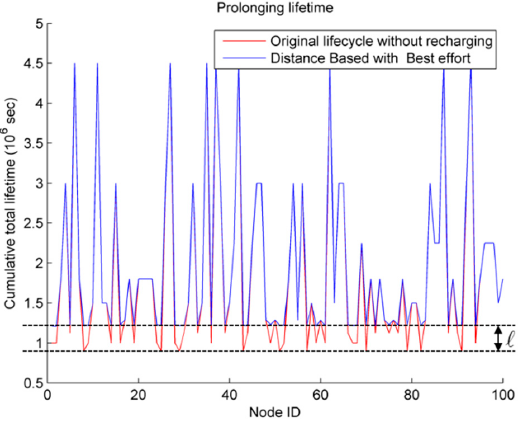
Figure 12. Extended lifetime of WRSNs.